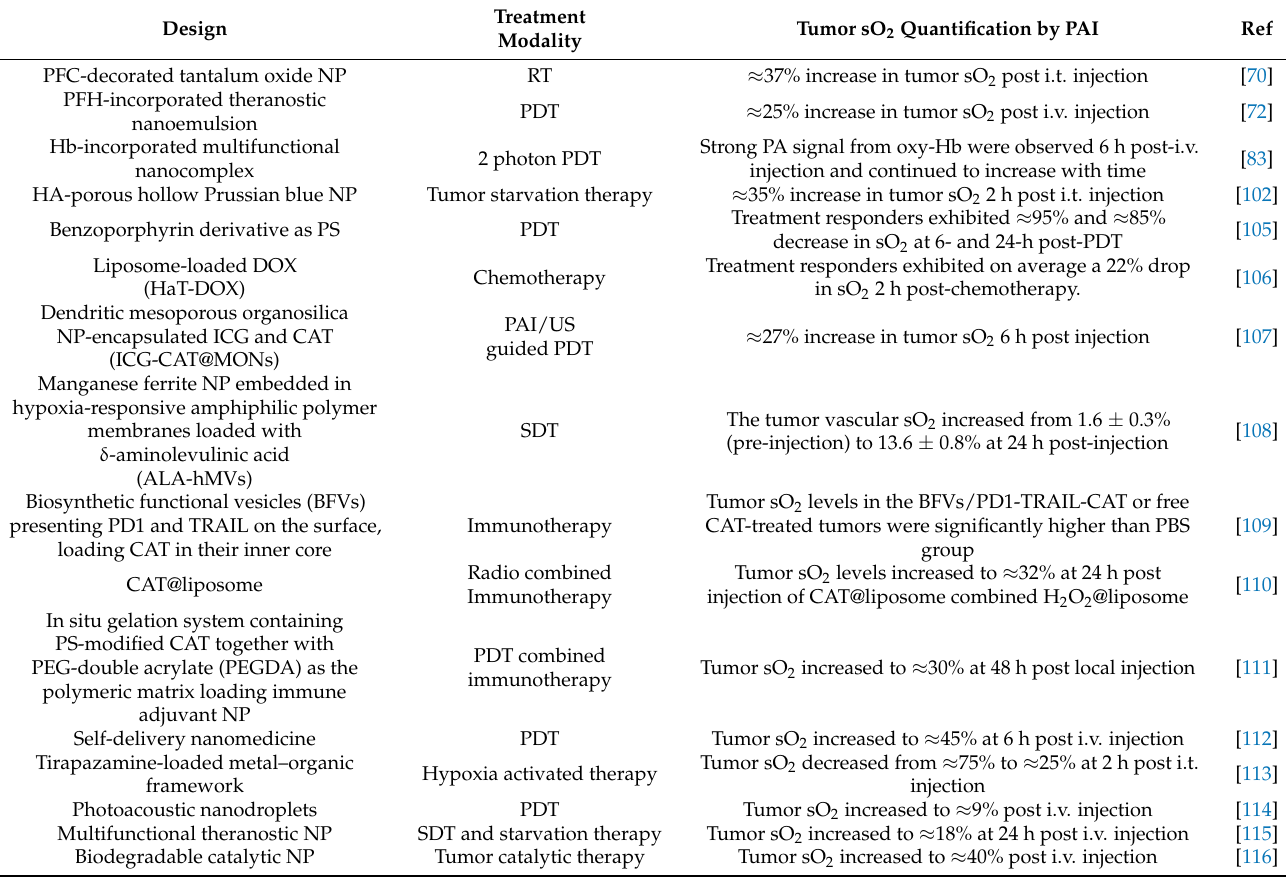
Table 1. Summary of NP-mediated tumor sO 2 increase quantified by